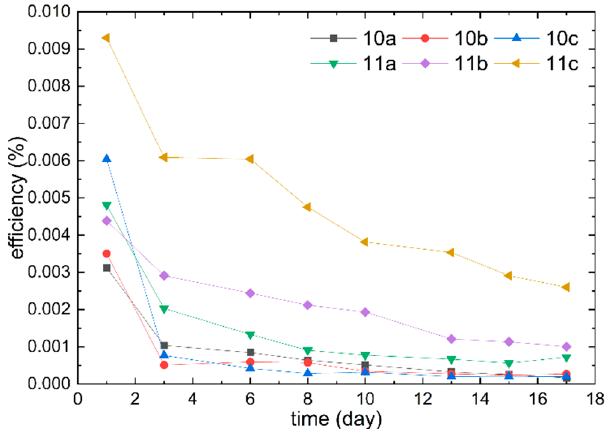
Figure 5. Temporal efficiency progressions of the DSSCs of samples 10 and 11. With sample 10 the